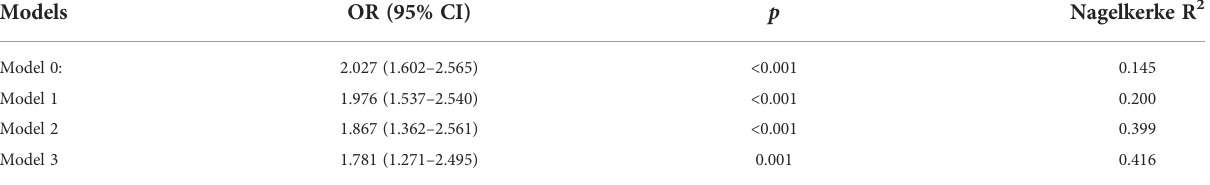
TABLE 3 Impacts of serum ADA levels (per 5 U/L increase) on the risk of DPN by multivariable logistic regression analysis.